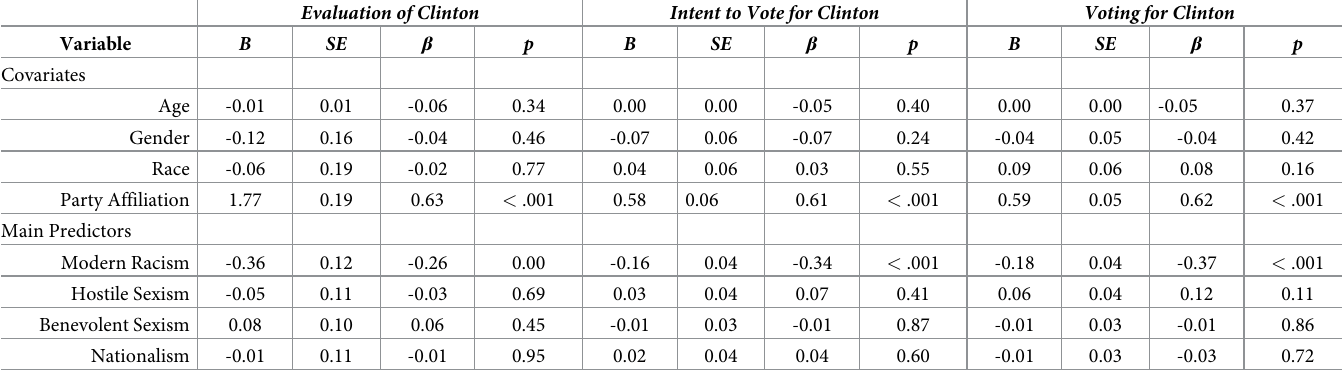
Table 6. Standardized estimates, unstandardized estimates, and standard errors for structural model predicting evaluation of Clinton, intent to vote for Clinton, and voting for Clinton at Time